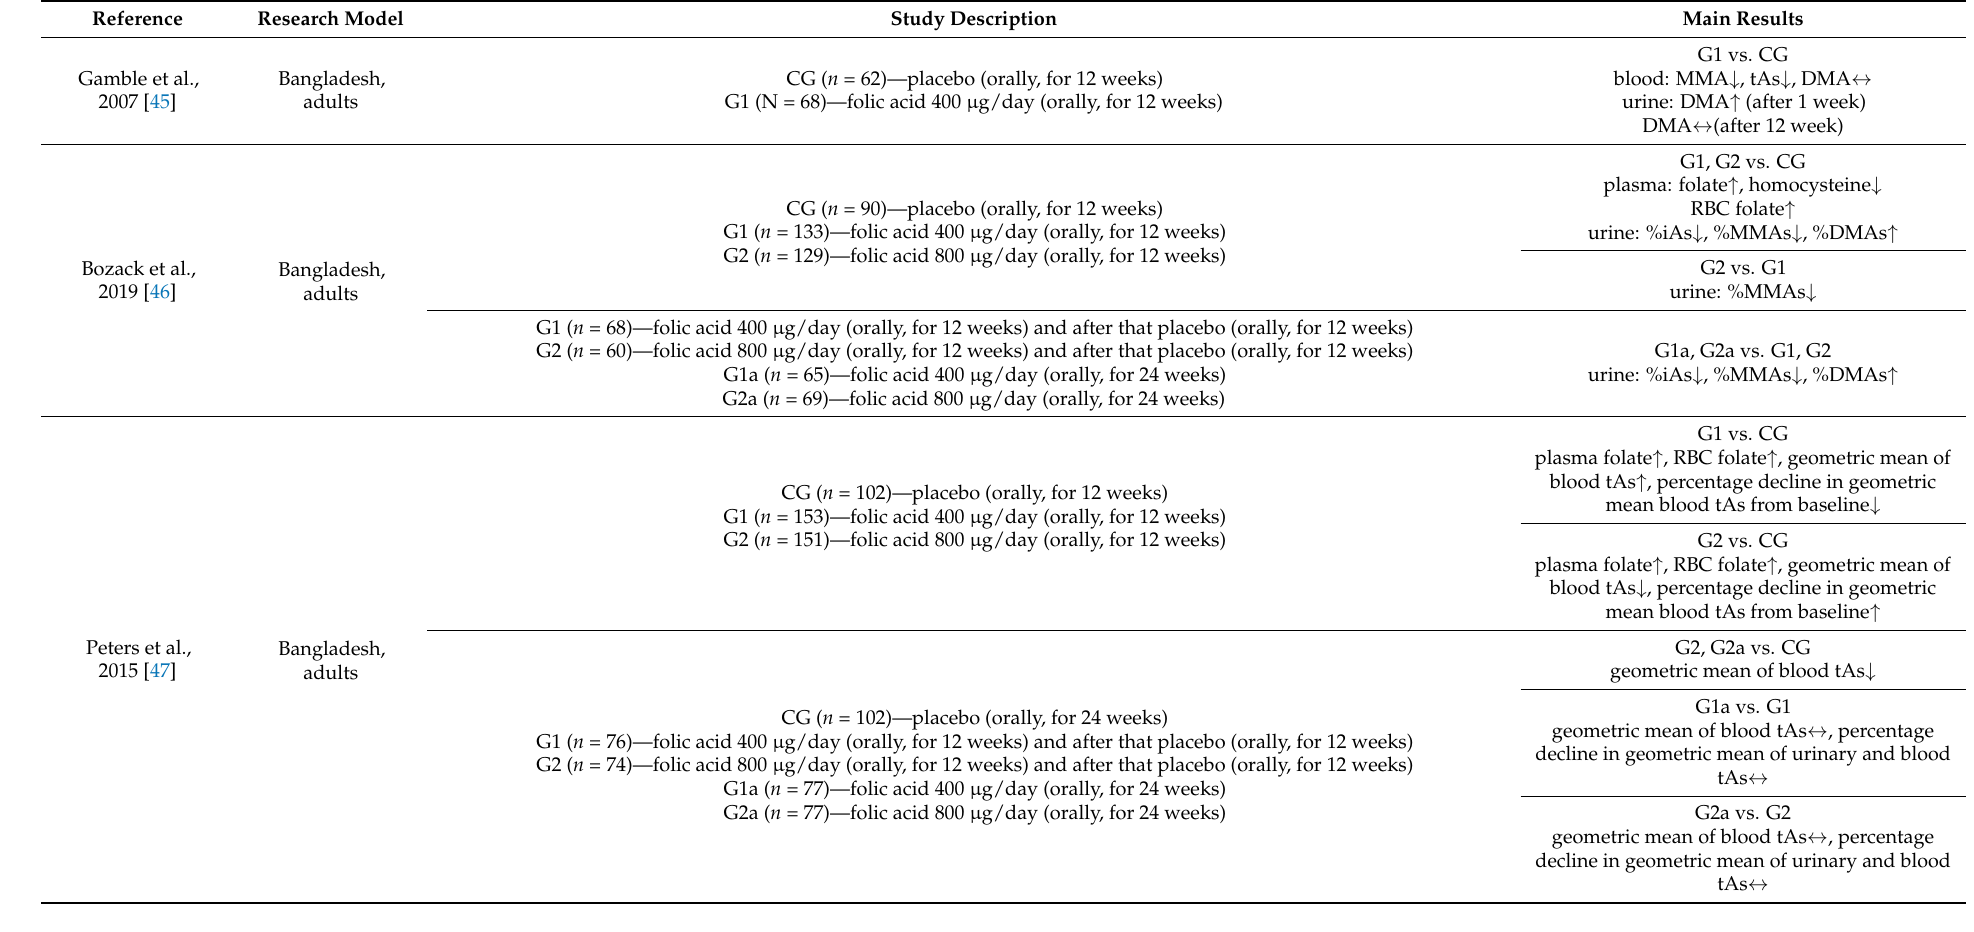
Table 3. Results of studies conducted in people with As exposure and supplementation with folic acid or